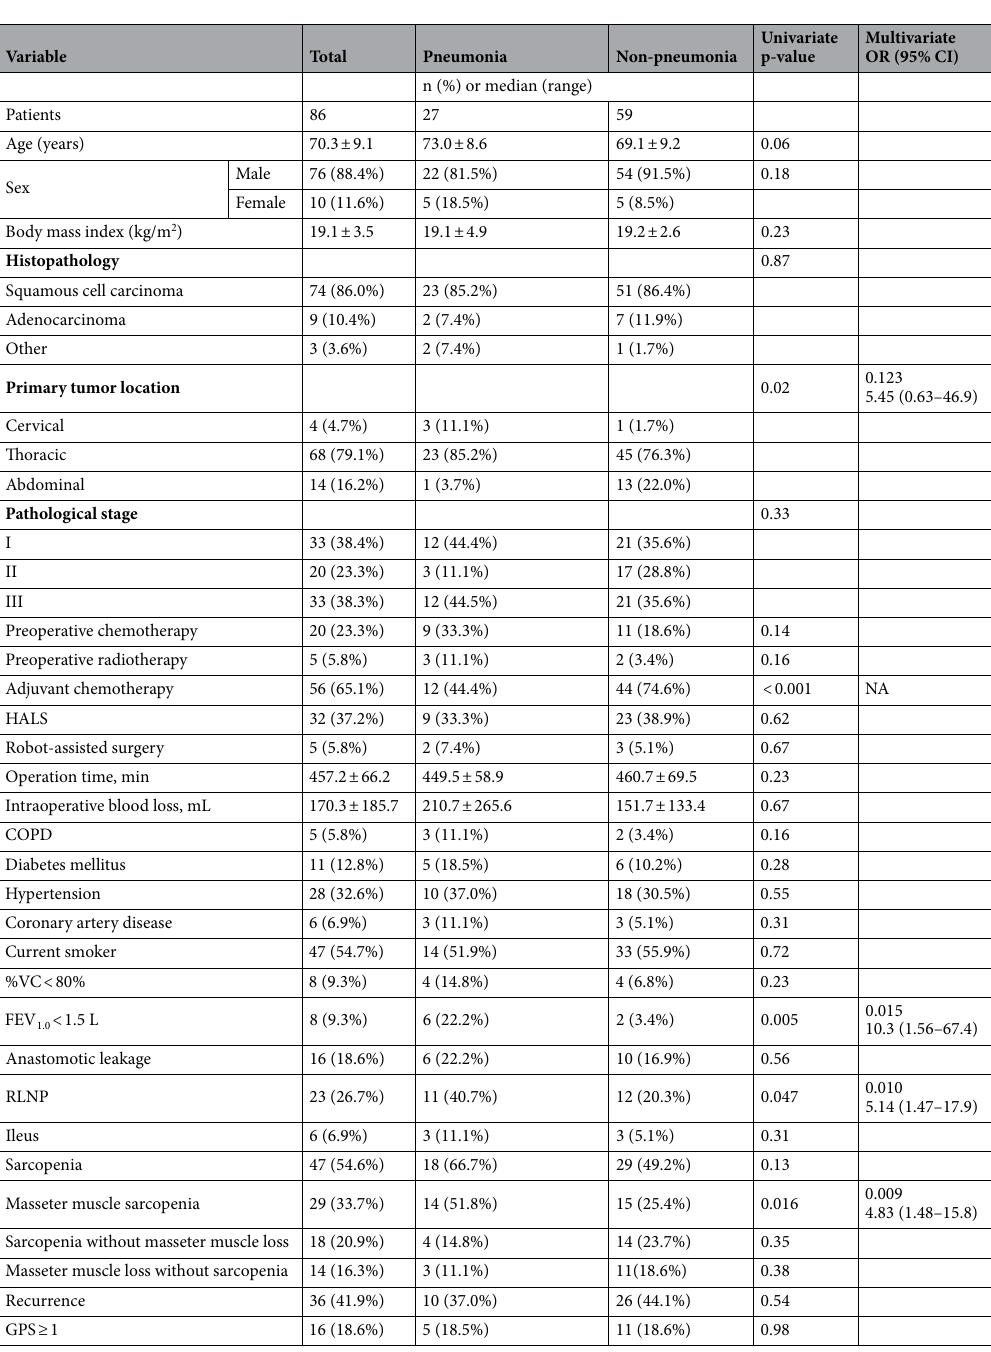
Table 1. Demographic and clinicopathological characteristics of the patient cohort. Preoperative and perioperative risk factors for pneumonia in patients undergoing esophagectomy. COPD, chronic obstructive pulmonary disease; %VC, vital capacity; FEV 1.0, forced expiratory volume in one second; HALS, hand-assisted laparoscopic surgery; RLNP, recurrent laryngeal nerve paralysis; GPS, Glasgow prognostic